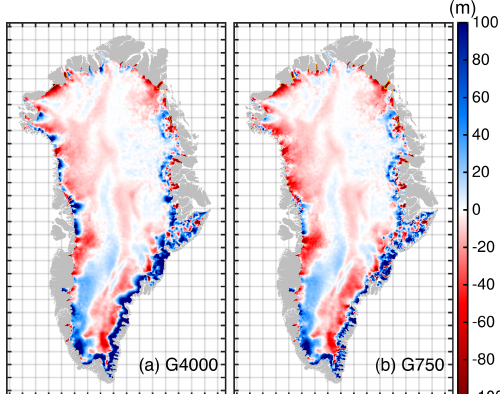
Figure 7. Difference in ice thickness between 2100 and 2015 for the ctrl run. (a) G4000 simulation and (b) G750 simulation. The grey silhouette shows the Greenland land mask from BedMachine v3. Positive values represent thickening, and negative values show thin- ning. Thin yellow line shows the grounding line in the year